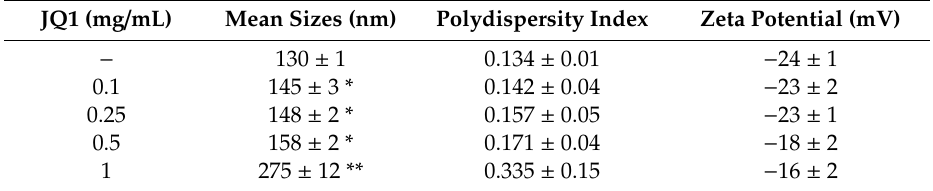
Table 1. Physico-chemical properties of poly-lactid-co-glycolic acid (PLGA) nanosystems loaded with JQ1. JQ1 (mg /